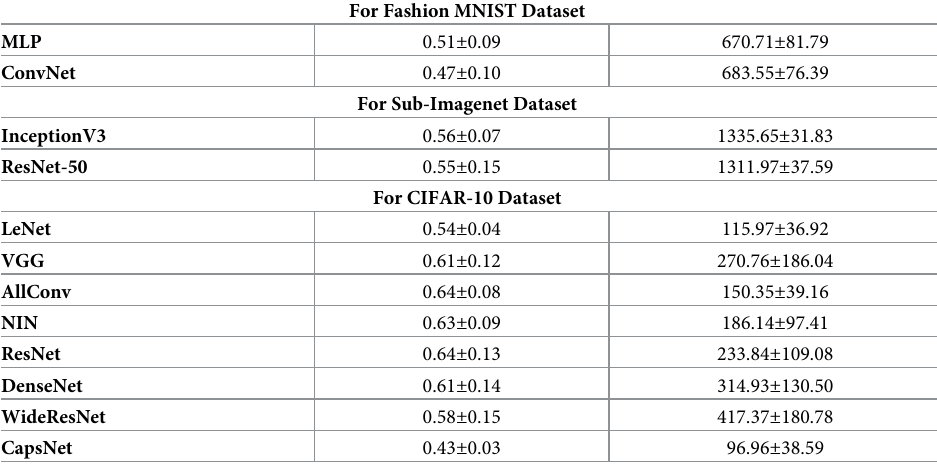
Table 1. Mean and standard deviation of Davies–Bouldin Metric (DBM) and Amalgam Metric (AM) scores for vanilla Raw Zero-Shot